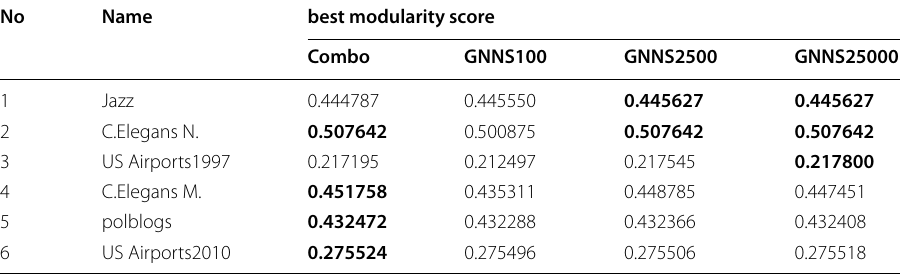
Table 6 Achieved modularity scores for the original directed configurations of the classical network